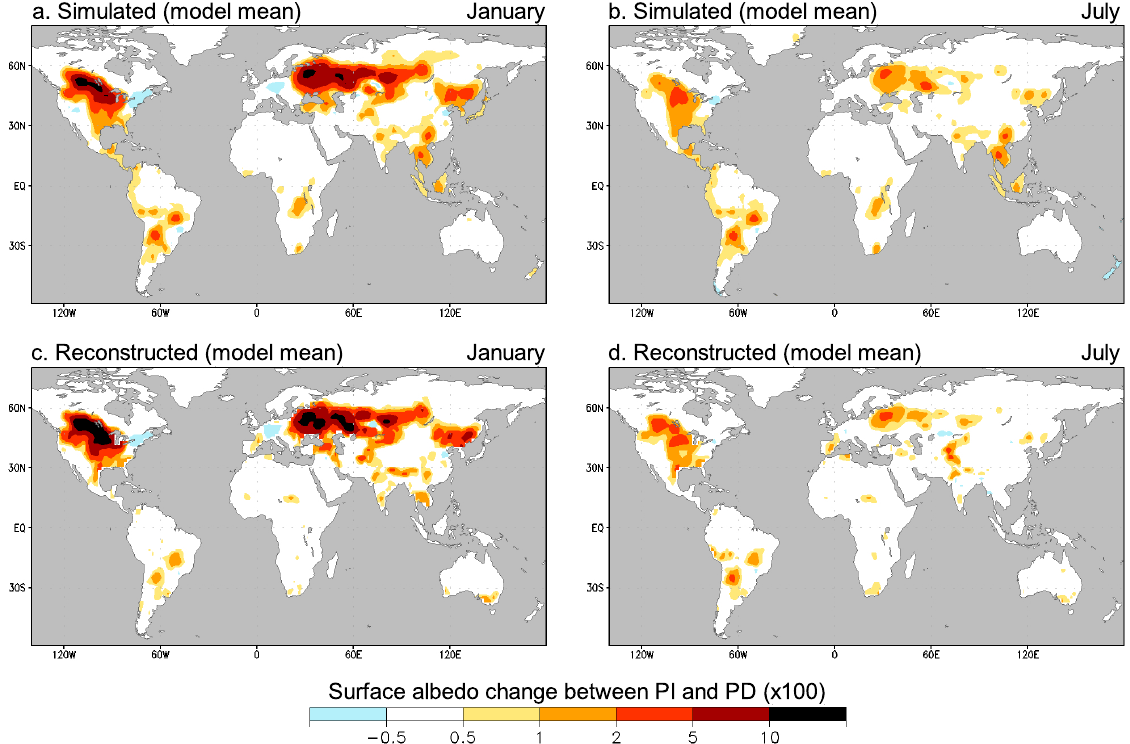
Fig. 6. LCC-induced surface albedo change (present-day minus preindustrial) in January (a) , (c) and July (b) , (d) . Maps (a) and (b) indicate the model-mean albedo change directly obtained from LUCID simulations. Maps (c) and (d) illustrate the albedo change obtained from the MODIS-based reconstructions (the albedo change computed with the different LUCID models’ land cover maps are averaged). Note the non-linear scale.